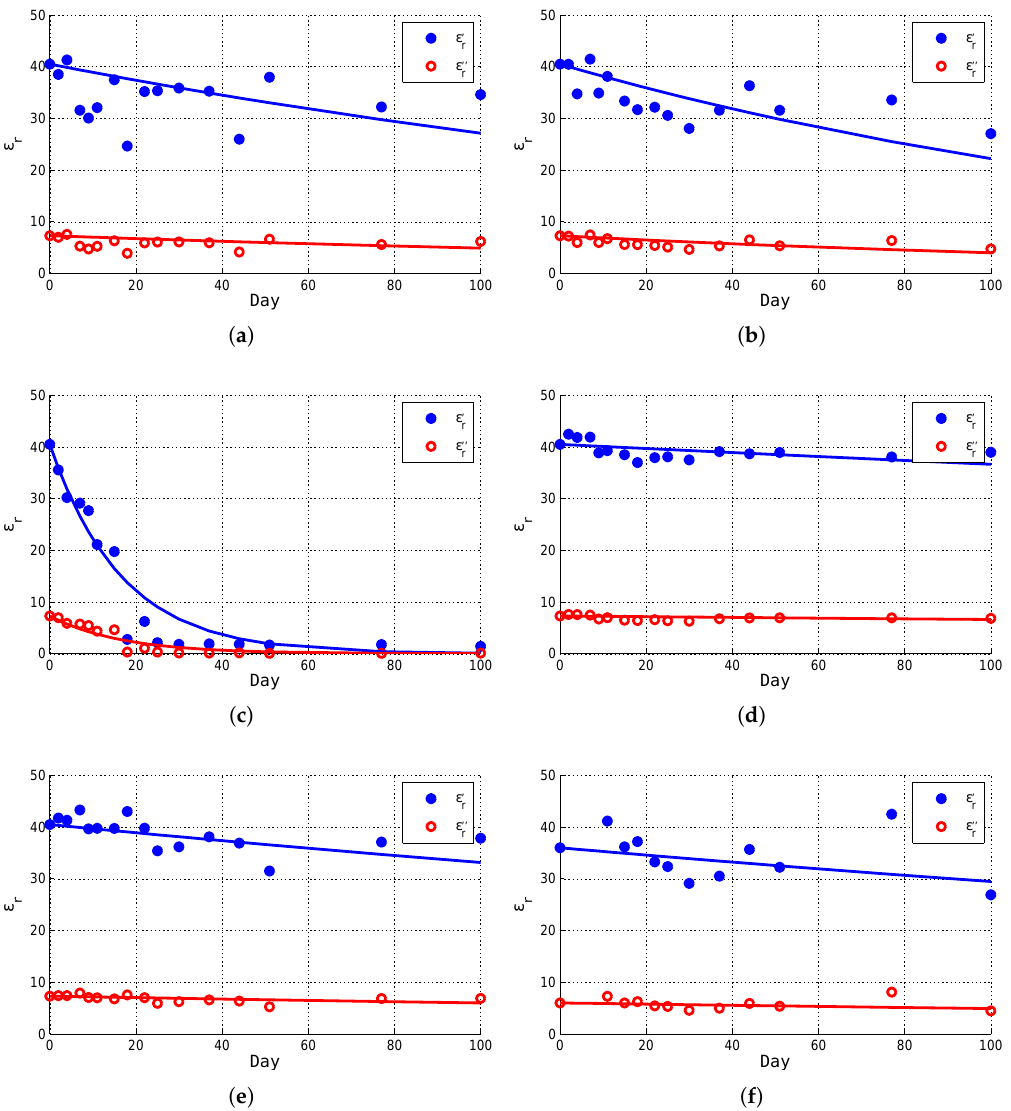
Figure 13. Time evolution of the phantom samples measured relative permittivity. ( a ) Sample 1 (Parallelliped, Plastic). ( b ) Sample 2 (Parallelliped, Cling-film). ( c ) Sample 3 (Parallelliped, Open). ( d ) Sample 4 (Cilindrycal, Plastic). ( e ) Sample 5 (Cilindrycal, Plastic). ( f ) Sample 6 (Parallelliped, Plastic, one